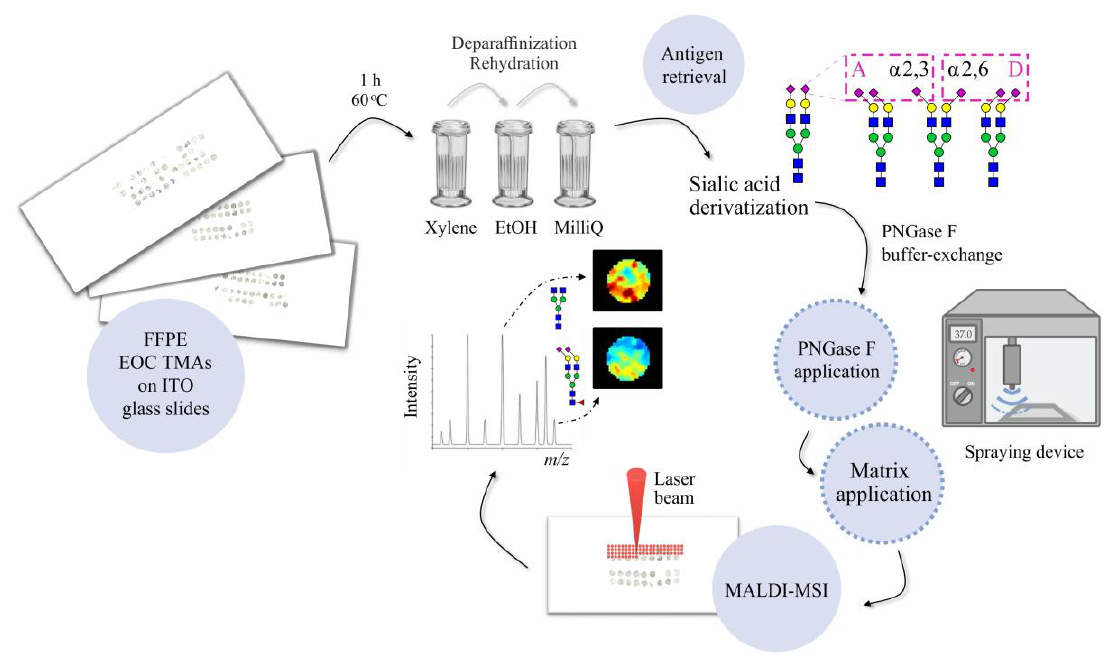
Figure 1. Schematic representation of the analytical workflow used in this